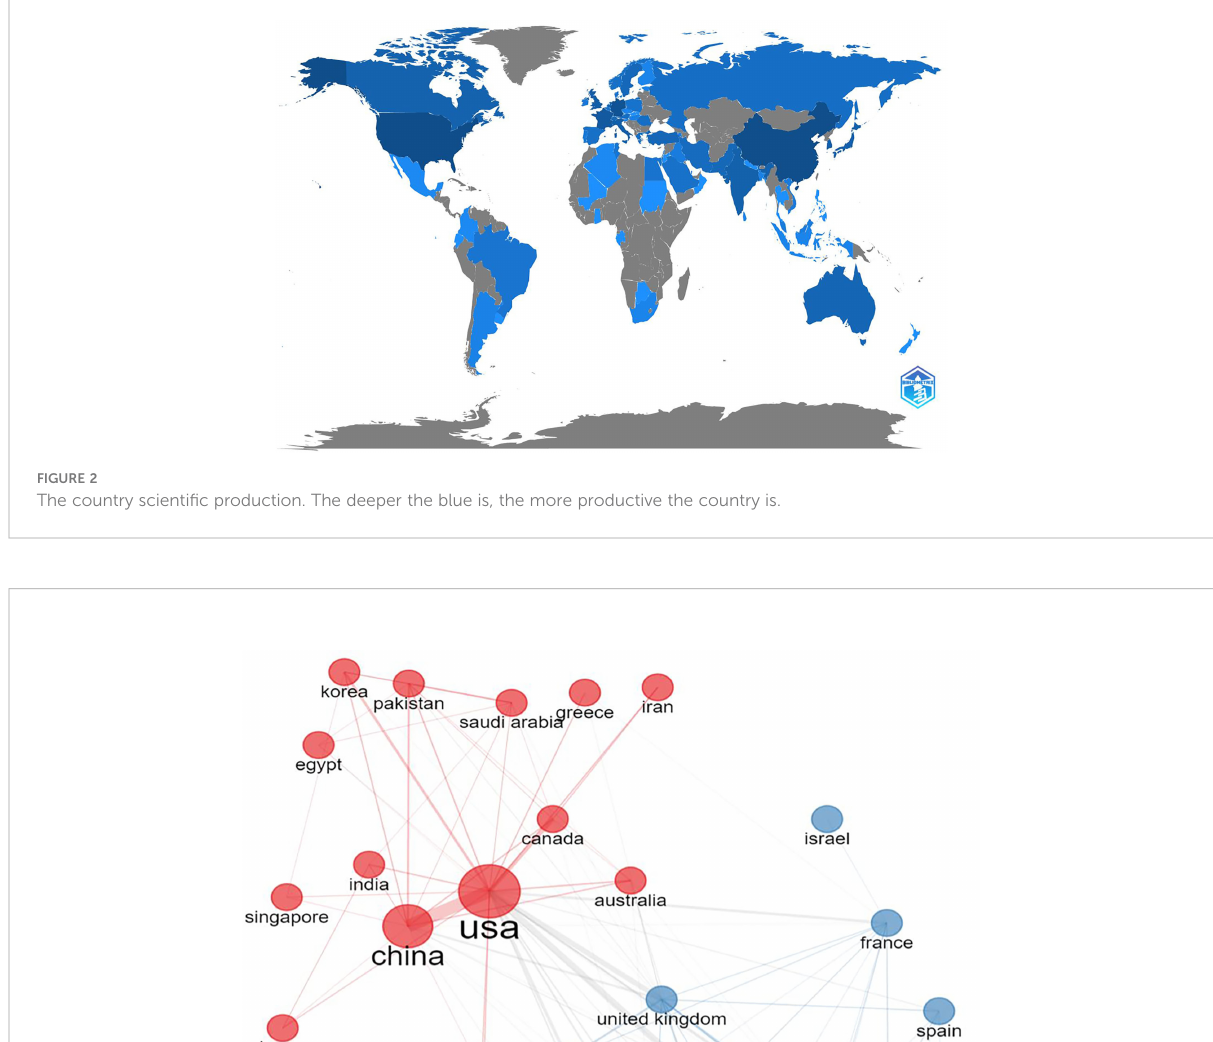
published articles in the high-ranked journals.